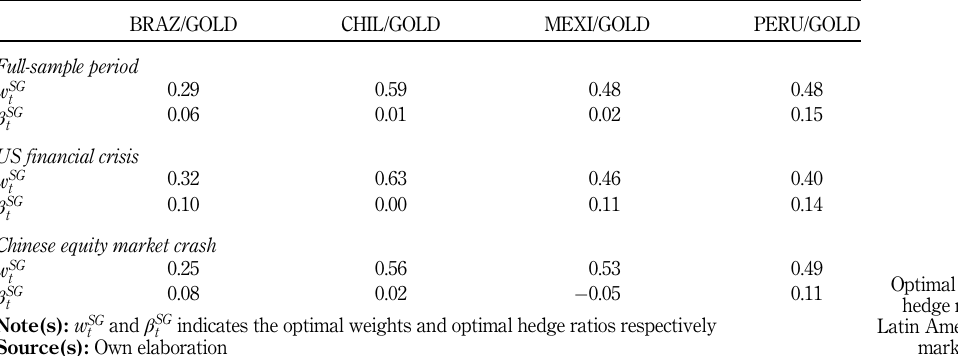
Table 6. Optimal weights and hedge ratios for the Latin American equity markets and